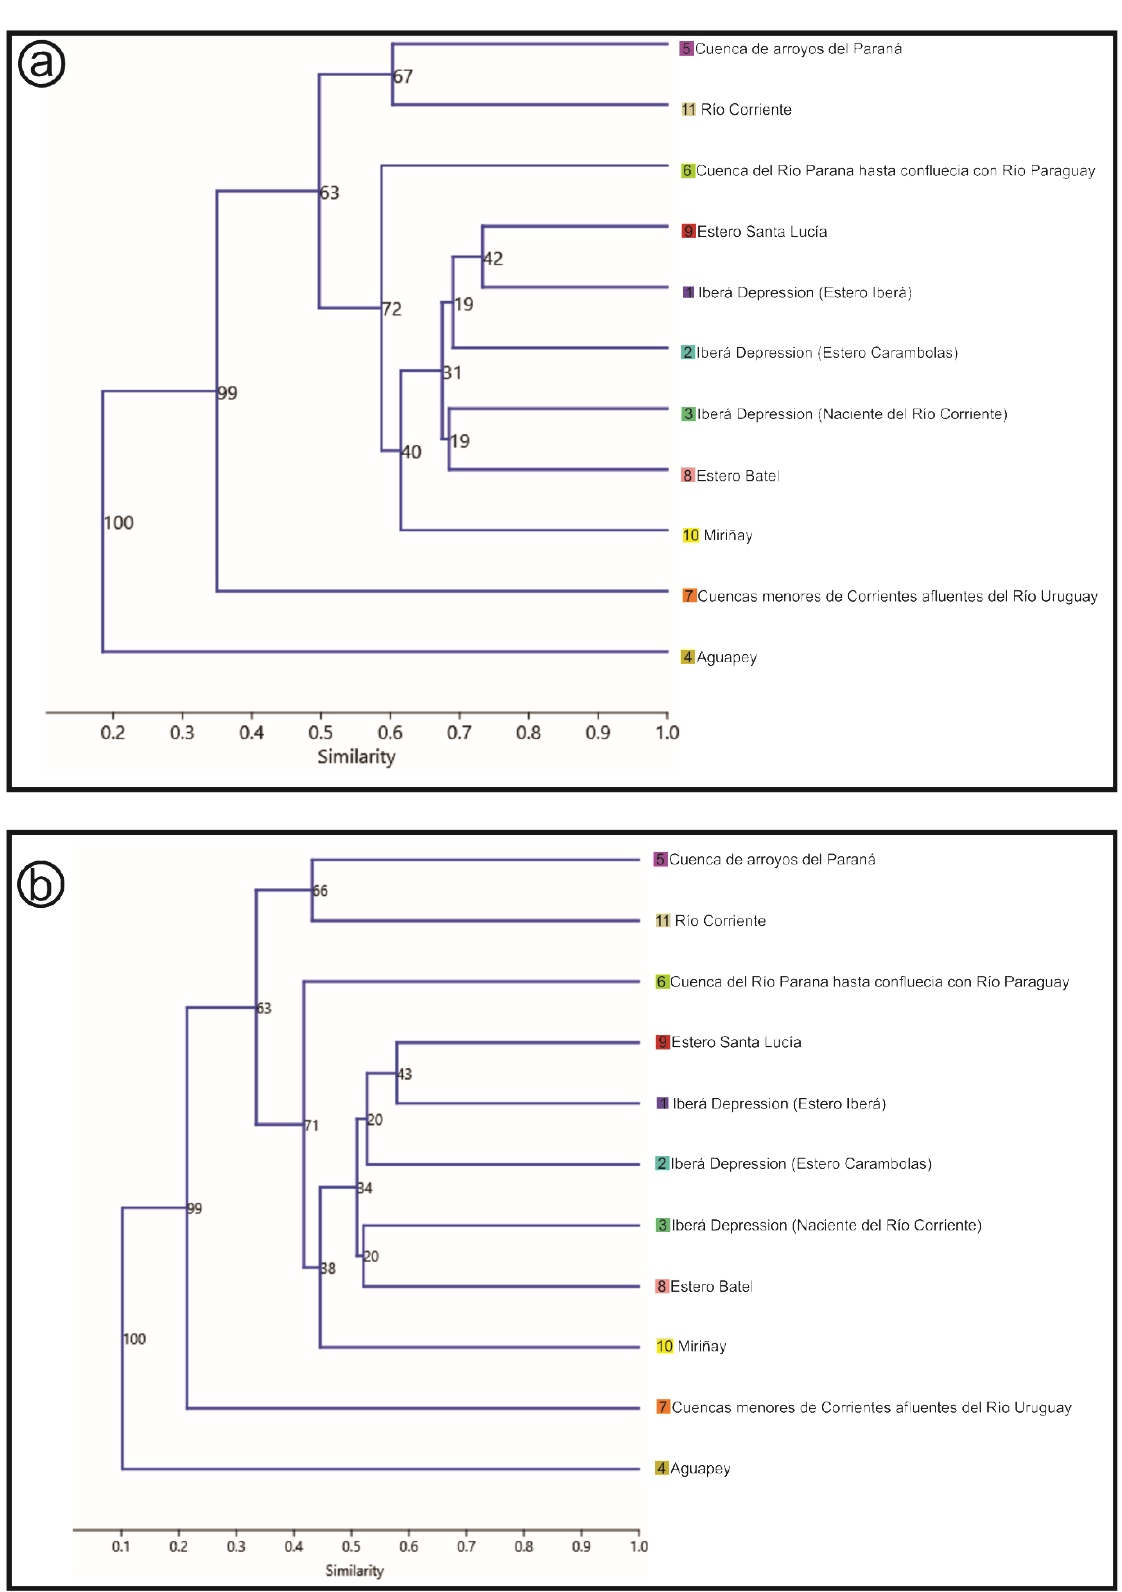
Figure 8. ( a ) Dendrogram showing similarity between hydrological basins (Sorensen – Dice), CC > 0.96, ( b ) Dendrogram showing similarity between hydrological basins (Jaccard), CC > 0.96. The β diversity analysis shows the highest similarity for the cluster Iberá -Santa Lu- cia (J > 0.5, D > 0.7) and Batel-Naciente del Río Corriente (J > 0.5, D > 0.65). On the other